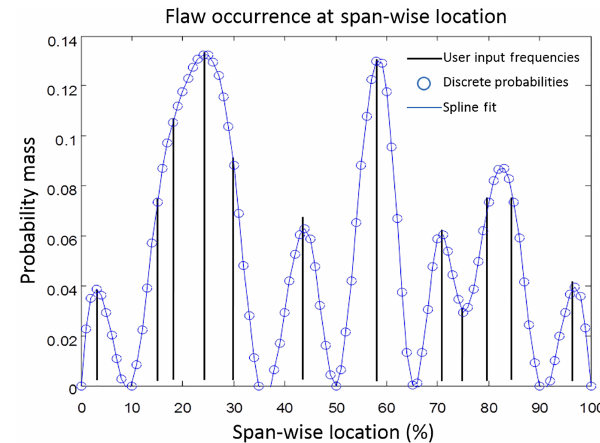
Figure 10. Probability of flaw mass, or occurrence, spatially dis- tributed along span-wise length.